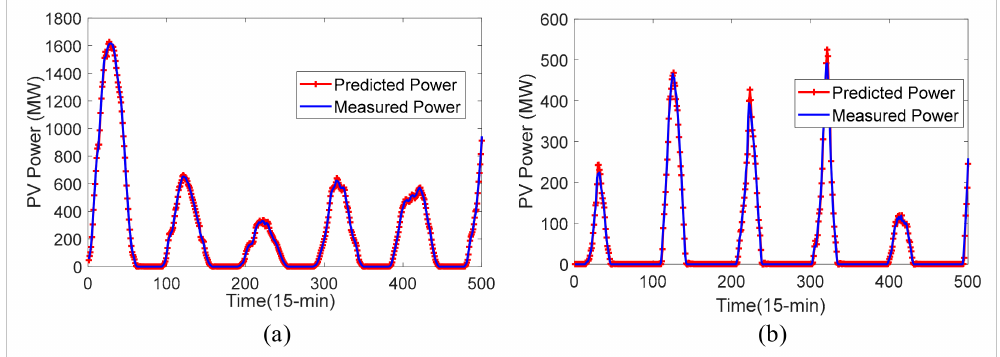
Figure 7. 15-min ahead of the PV power forecasting results. ( a ) Case 1; ( b ) Case